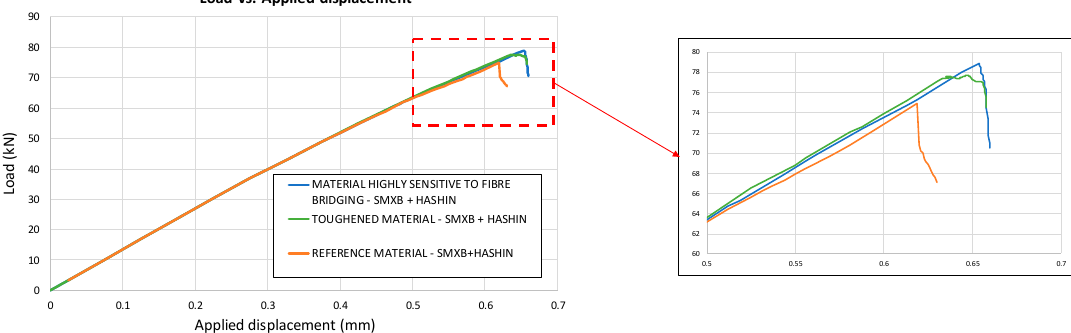
Figure 15. Load vs. Applied displacement (SMXB +